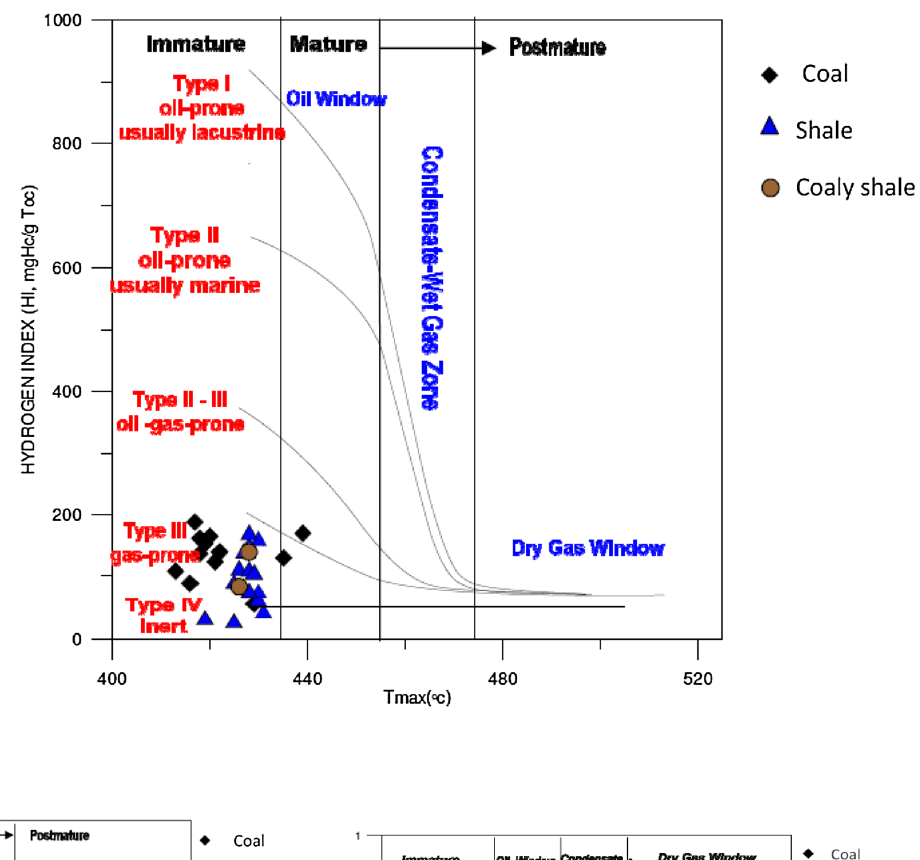
Fig. 9 Plot of hydrogen index (HI) against T max of coal, coaly shale and shale samples from Maiganga mine, Gongola Basin. Most of the samples are immature and fall within type III kerogen (gas prone) typical of terrestrially sourced organic matter